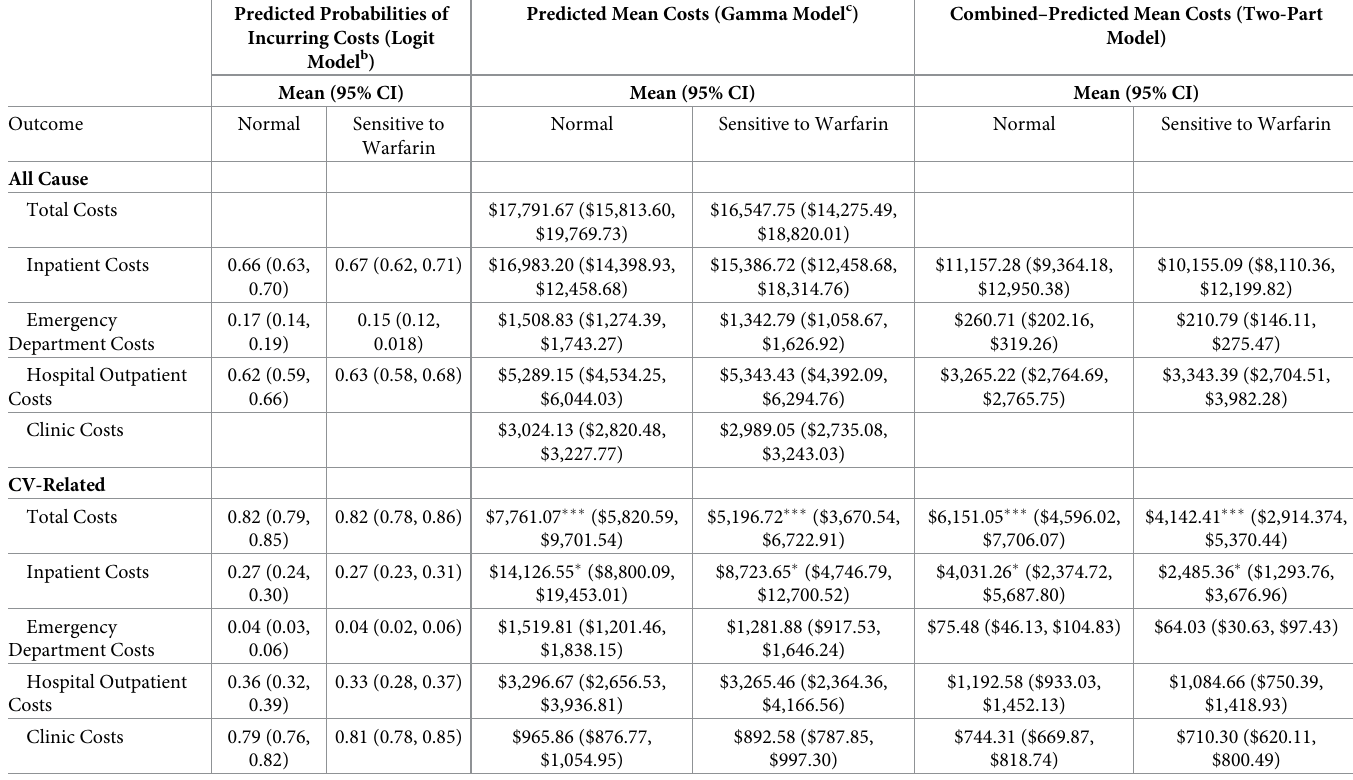
Table 5. Predicted probabilities of incurring costs and predicted average costs across exposure groups for warfarin sensitivity a . Predicted Probabilities of Incurring Costs